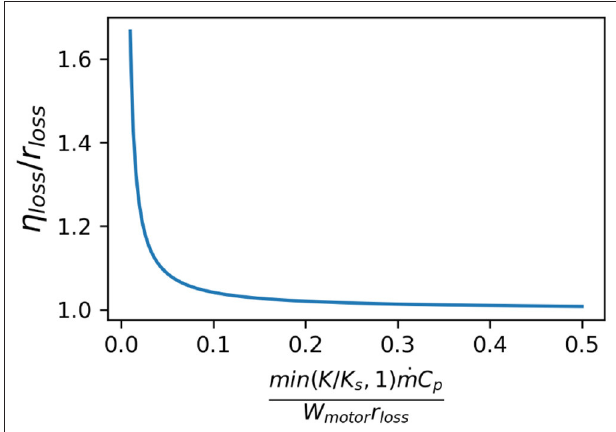
FIGURE 6 | The relationship between the resistance loss η loss to the lubricant thermal